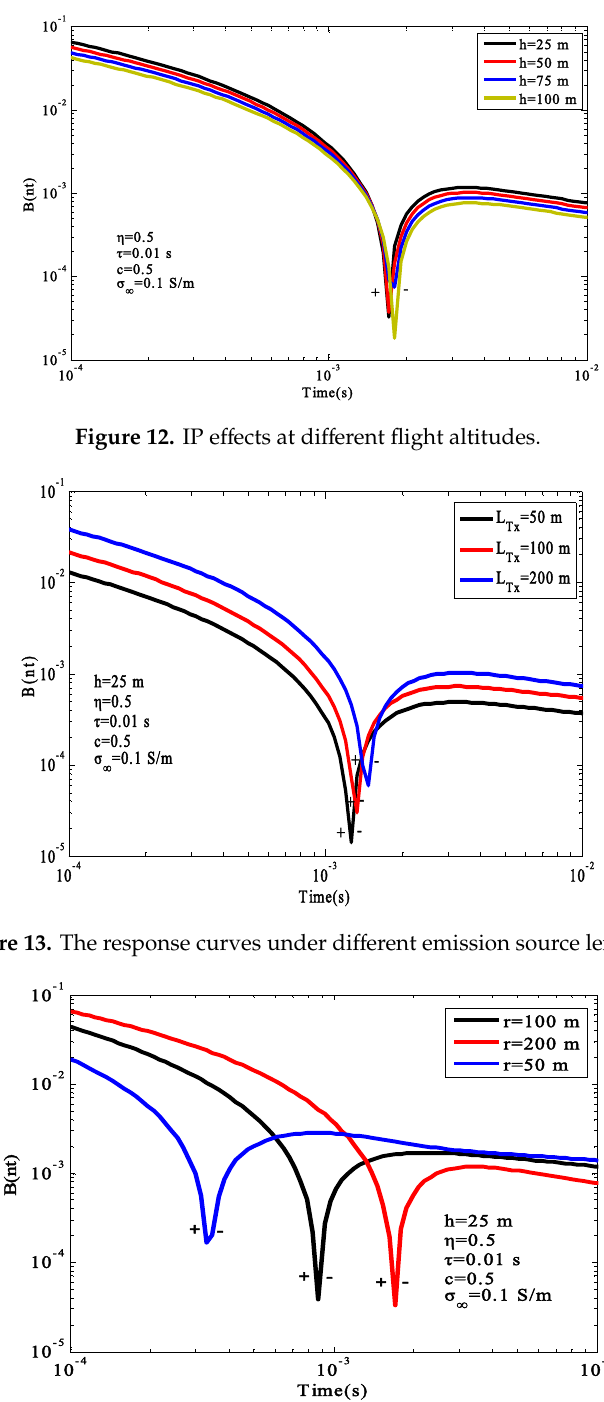
Figure 14. The response curves under different offset distances.